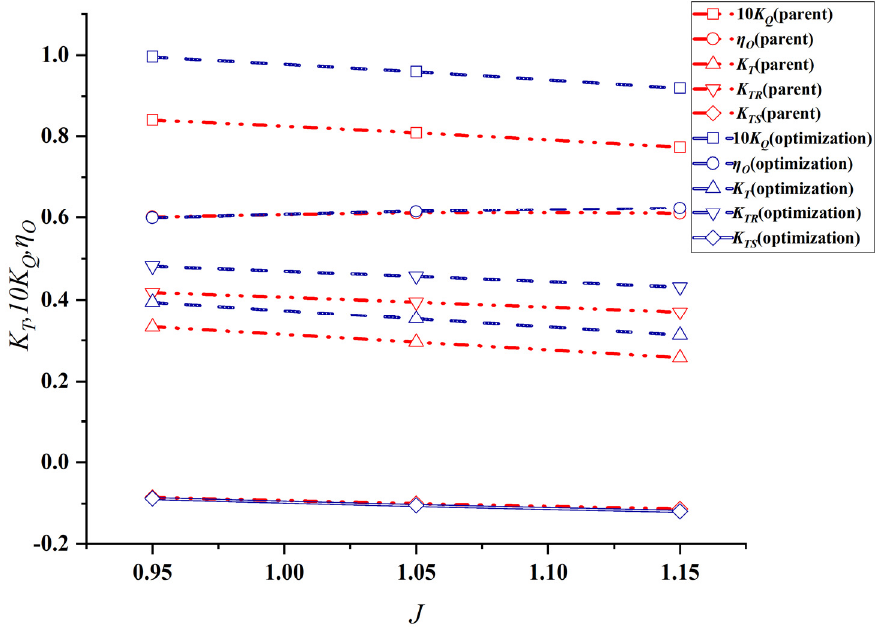
Figure 17. Comparison of open water performance of optimized pump-jet propulsion system and parent pump-jet propulsion system.